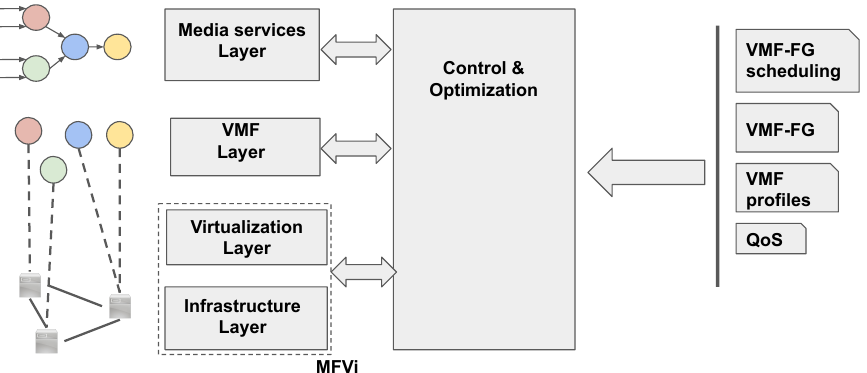
Figure 1. Overview of the MFV